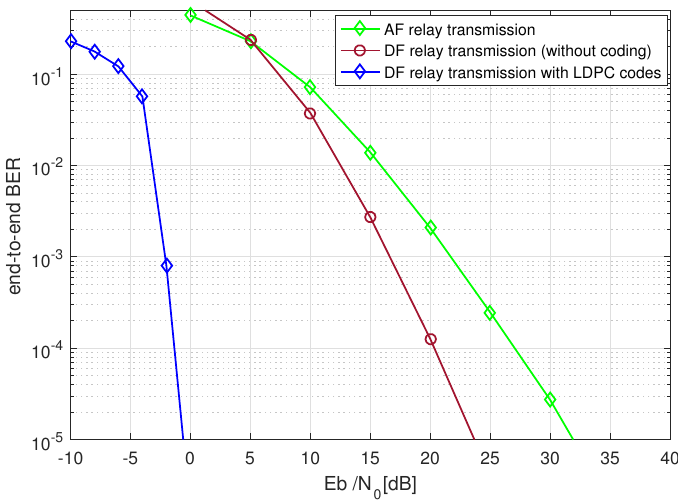
Figure 3. A BER (bit error rate) performance comparison between amplify-and-forward (AF), decode-and-forward (DF) coded, and non-coded relay assisted communications, LDPC code length n = 648, Nakagami- m fading, m 1 = m 2 = 3, 4-QAM (quadrature amplitude modulation), and no. of bits = 10 5